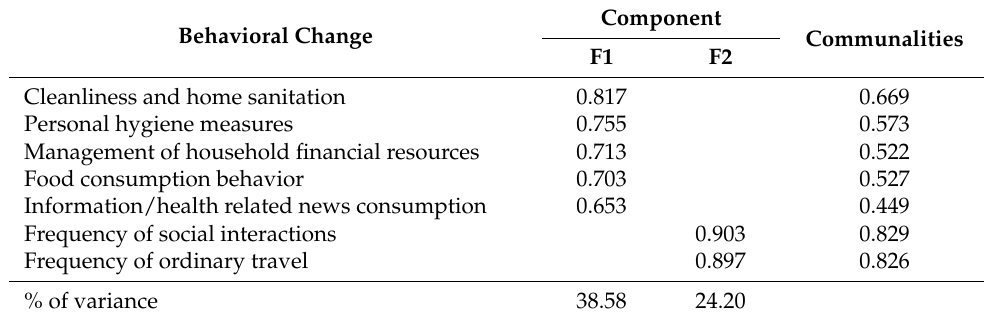
Extraction Method: Principal Component Analysis. Rotation Method: Varimax with Kaiser Normalization. a Rotation converged in 3